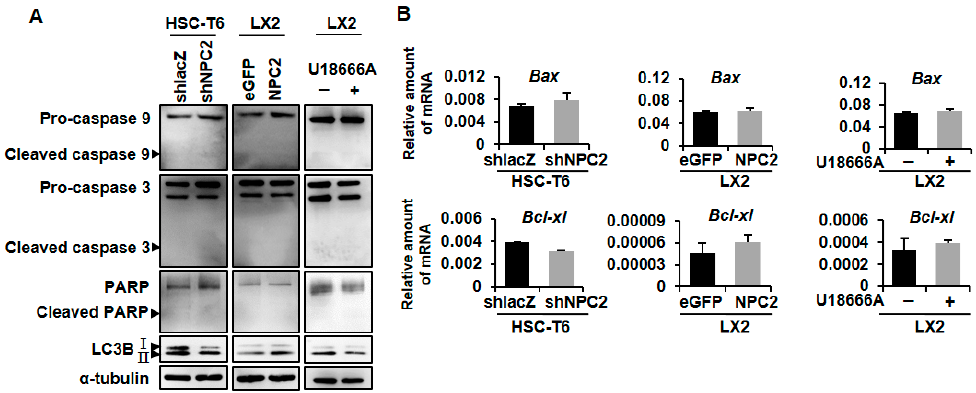
Figure 3. NPC2 expression and free cholesterol accumulation were not involved in the regulation of HSC apoptosis. ( A ) Protein expression of cleaved caspase 9, full caspase 9, cleaved caspase 3, full caspase 3, cleaved PARP, full PARP, LC3B, and α -tubulin was analyzed by using immunoblotting in NPC2-downregulated HSC-T6, NPC2-overexpressed LX2 and U18666A-treated LX2 cells; ( B ) Gene expression of pro-apoptotic Bax and anti-apoptotic Bcl-xl was analyzed by using real-time PCR in NPC2-downregulated HSC-T6 cells, NPC2-overexpressed LX2 cells, and U18666A-treated LX2 cells. Data are shown as mean ± SD. Each experiment was performed using three independent replicates. A similar phenomenon was observed, and representative data are shown in the figure.